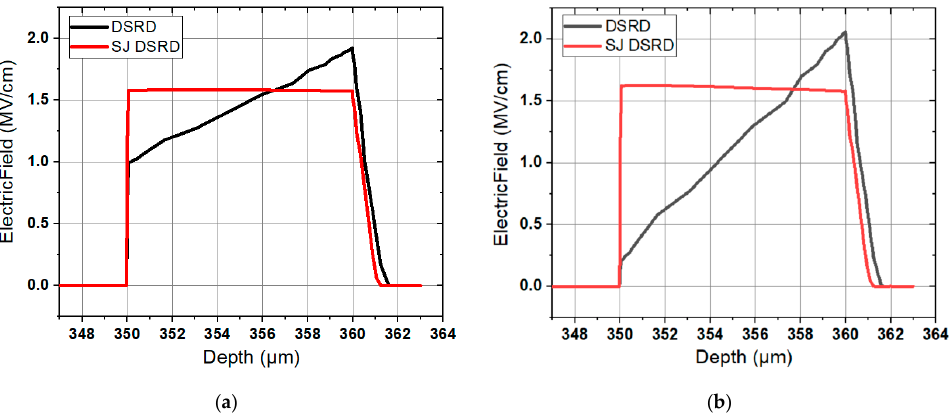
Figure 7. Comparison of electric field distributions of conventional SiC DSRD and SJ SiC DSRD with drift layer concen- trations of ( a ) 5 × 10 15 cm − 3 and ( b ) 1 × 10 16 cm − 3 respectively.